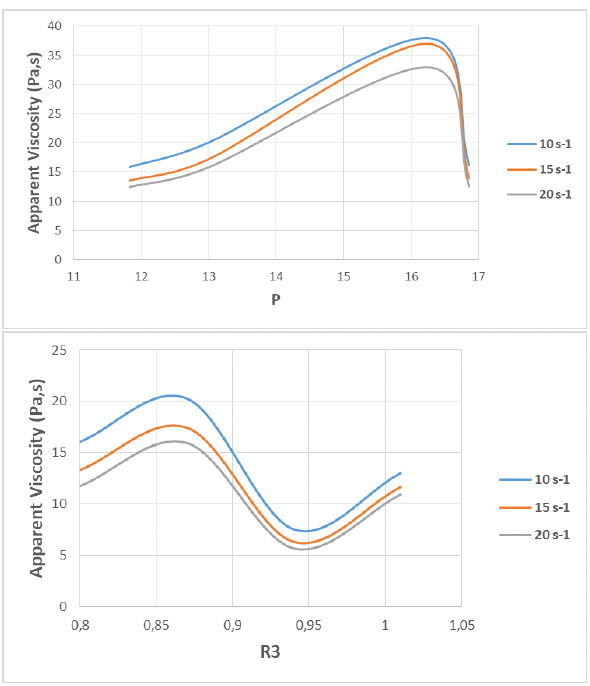
Figure 8: Evolutions of the apparent viscosity for a different shear rate and as function of P and